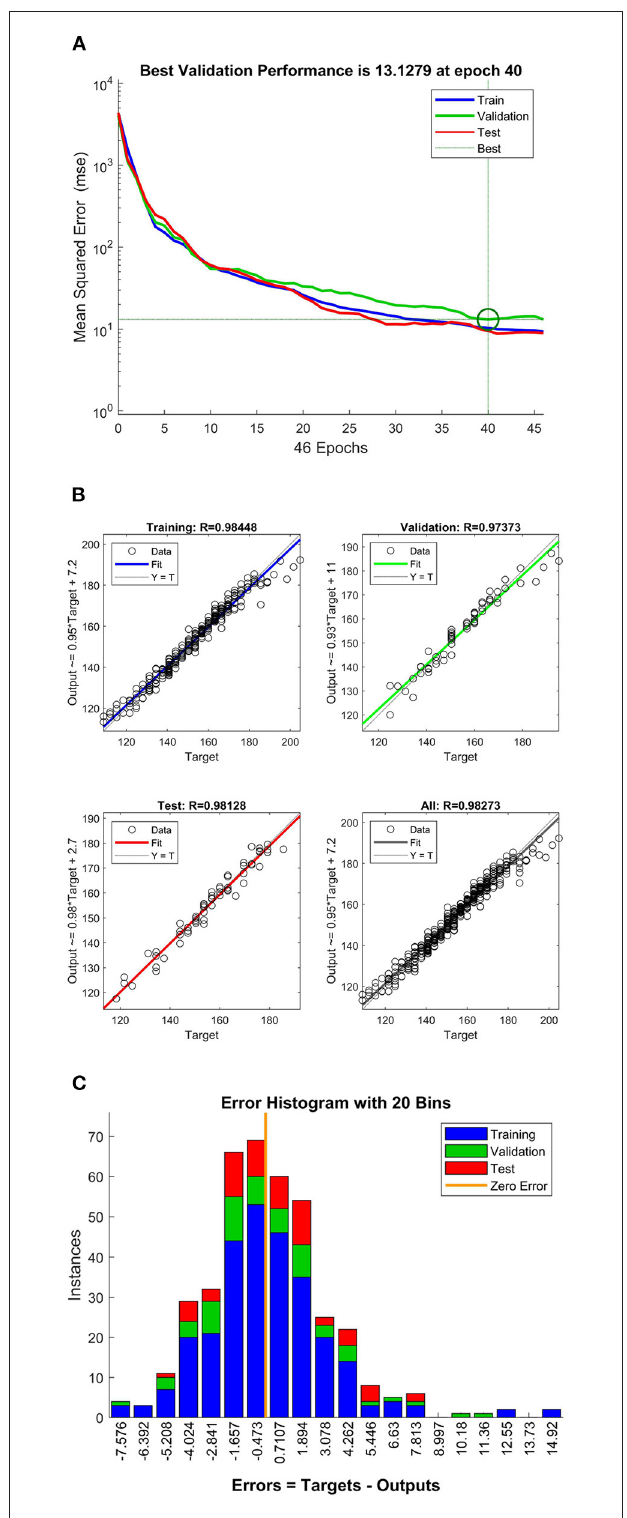
FIGURE 1 | Training process of the model; (A) convergence characteristics; (B) regression performance of the model; (C) error histogram of the model.